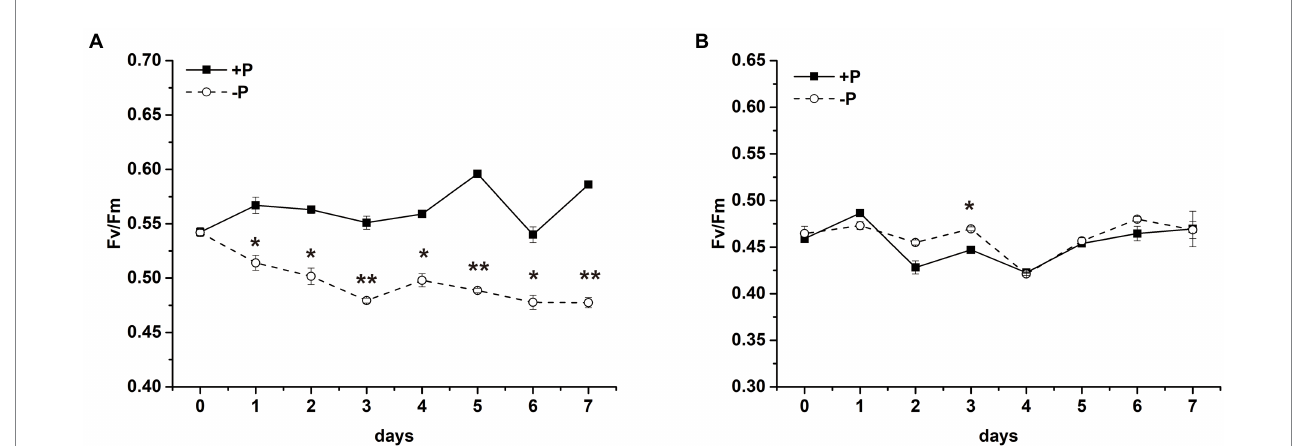
FIGURE 2 Maximum photochemistry efficiency (F v /F m ) of S . costatum (A) and P . globosa (B) in +P and − P groups. Error bars show the mean ± standard error (SE) of triplicate treatments. Superscripts indicate significant differences between +P group and − P group according to a two-way ANOVA with a post-hoc test (** p < 0.01, * p <